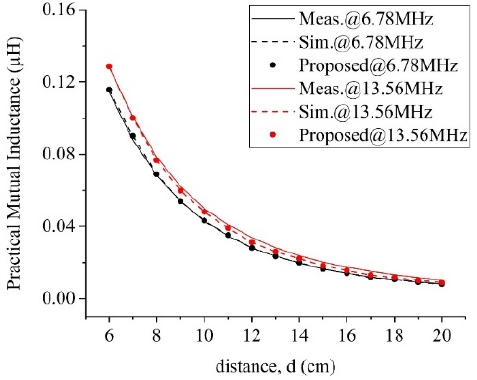
Figure 8. Practical mutual inductance between two coils with distance.